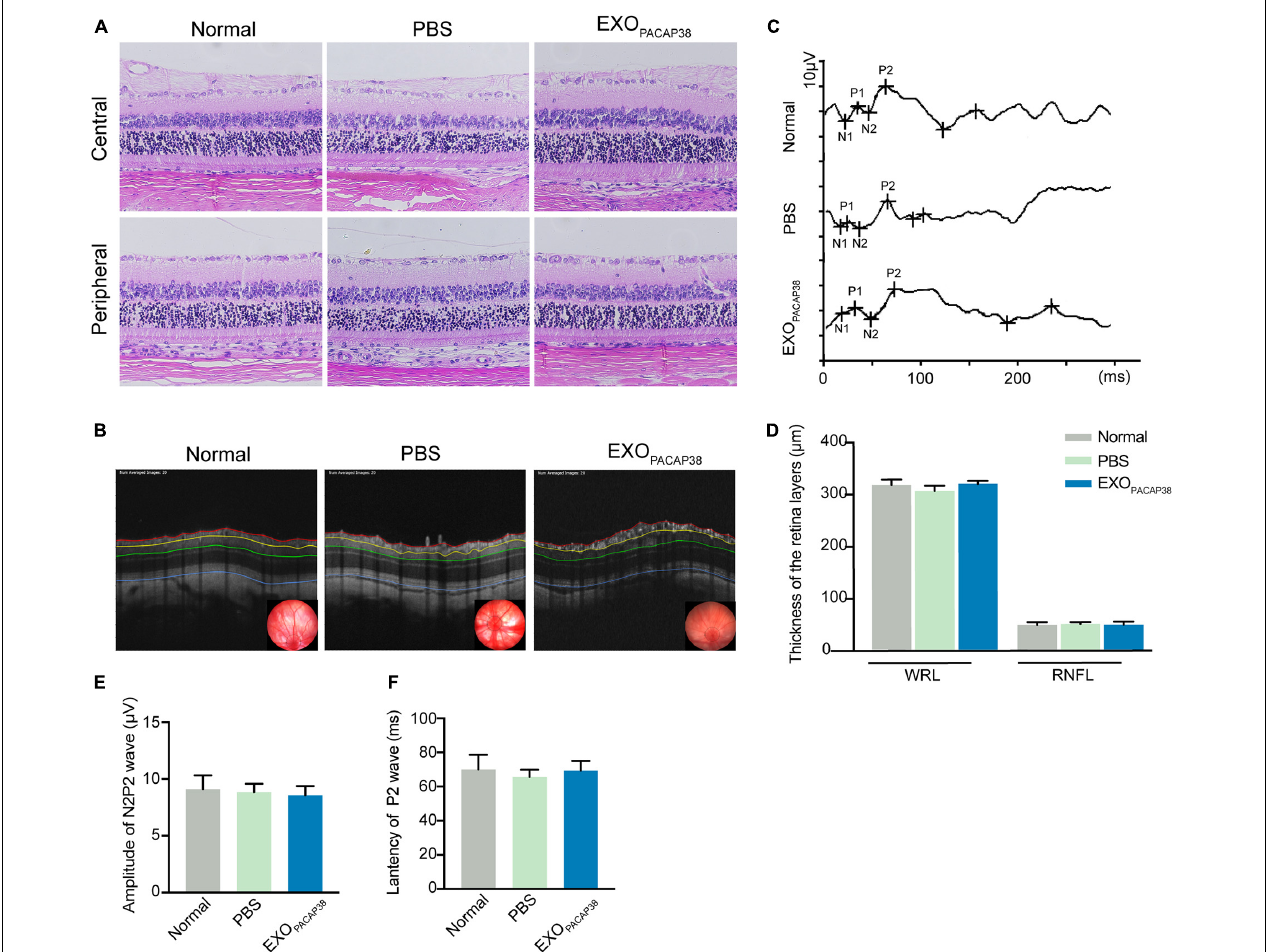
FIGURE 5 | Intravitreal injection of EXO PACAP 38 to rat eyes did not cause any toxicity to the retina. (A) H&E staining of retinal sections showing the morphology of the central (top) and peripheral (bottom) parts of retinal tissues in the normal control, vehicle (PBS)-treated, and EXO PACAP 38 -treated groups. (B) Representative OCT images showing the thickness of different layers of the retina within a range of 3600 µ m in circumference with the optic disc as the center (black circle) at 14 days after injury in the normal control, vehicle (PBS)-treated, and EXO PACAP 38 -treated groups. RNFL refers to the distance between the red and yellow lines. The whole retinal layer (WRL) refers to the distance between red and blue lines. (C) Quantitative analysis of the mean thickness of the RNFL and WRL of rats at 14 days. No significance in the mean thickness of the RNFL or WRL was observed at 14 days among the normal control, PBS-treated, and EXO PACAP 38 -treated groups ( n = 3; values are mean ± SEM, one-way ANOVA). (D) F-VEP was recorded at 14 days in the normal control, PBS-treated, and EXO PACAP 38 -treated groups. (E,F) EXO PACAP 38 did not induce F-VEP changes. No significant improvement in the amplitudes and latencies of the P2-wave was achieved at 14 days after injury among the normal control, PBS-treated, and EXO PACAP 38 -treated groups ( n = 4; values are mean ± SEM, one-way